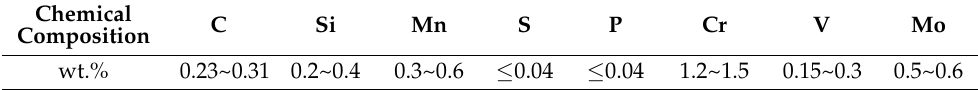
Table 1. The chemical composition of the 27CrMoV substrate with the exception of the element of Fe. Chemical